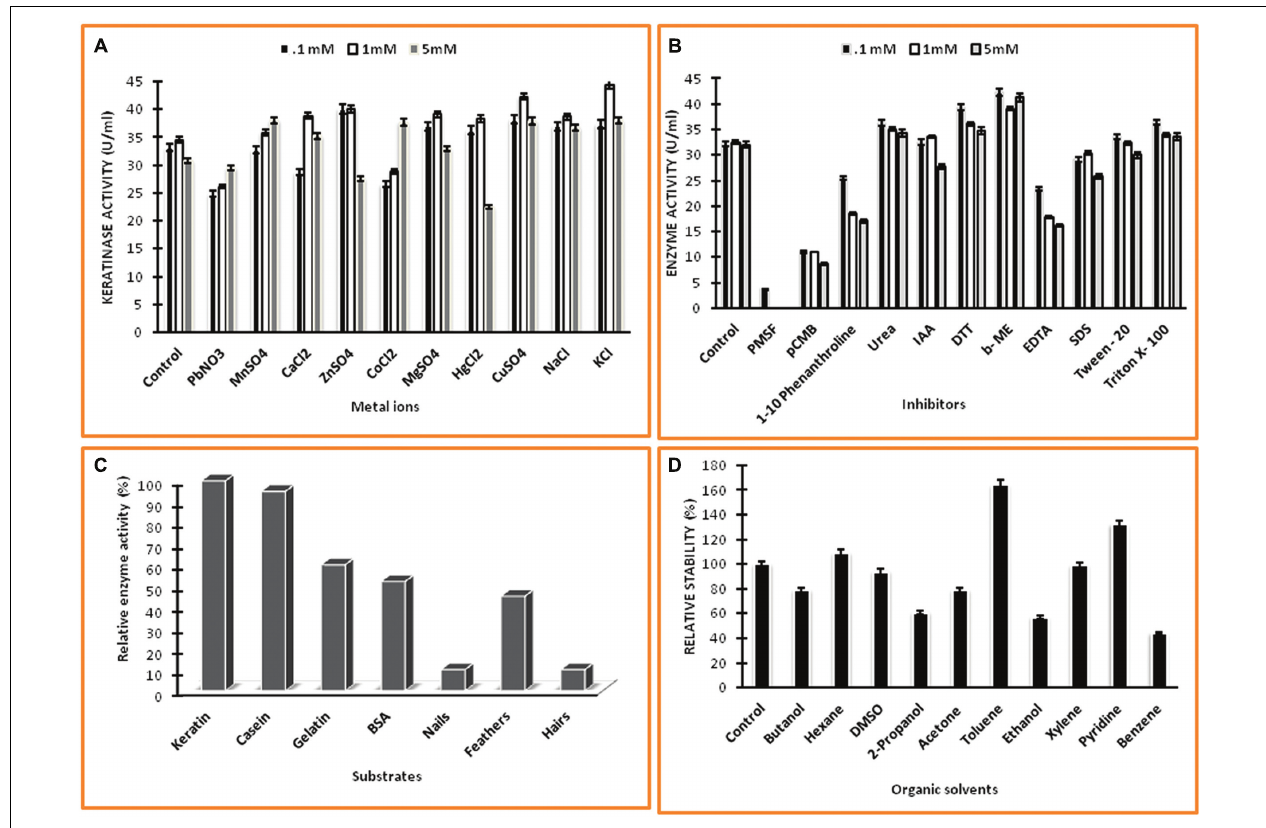
FIGURE 6 | Characterization of keratinase from Thermoactinomyces sp. RM4. (A) Effect of different metal ions on keratinase enzyme activity at different concentrations of 0.1, 1.0, and 5.0 mM; (B) Effect of different chemicals on enzyme activity at different concentrations of 0.1, 1.0, and 5.0 mM; (C) Substrate specificity of keratinase; (D) Effect of organic solvents on enzyme activity.